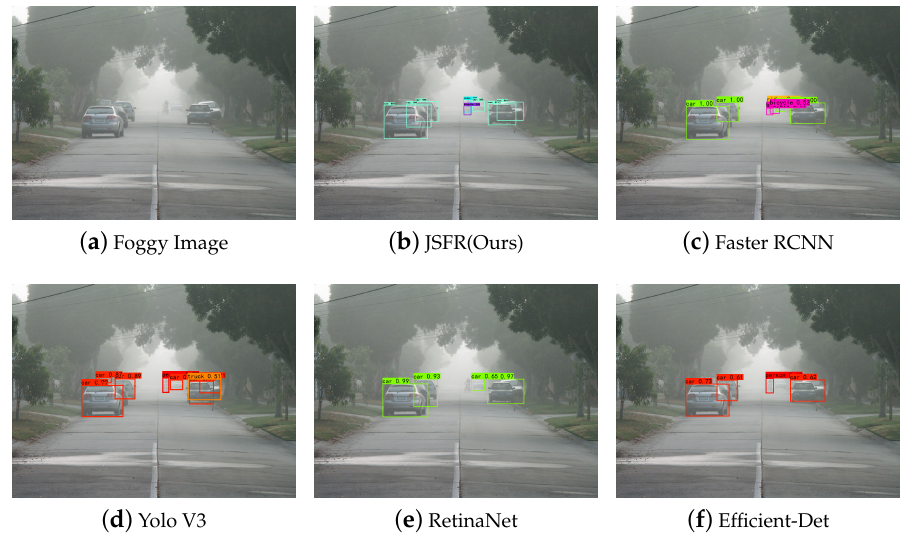
Figure 10. Testing results of JSFR and object detection methods including Faster RCNN , Yolo V3 , RetinaNet , and Efficient-Det on Foggy Driving Dataset (electronic zoom-in recommended).